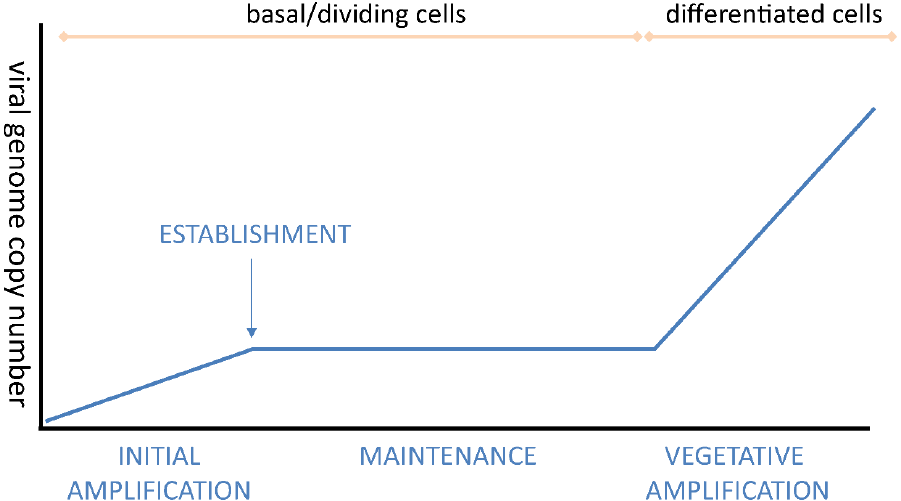
Figure 3. Viral Genome Copy Number during the Different Phases of Replication.